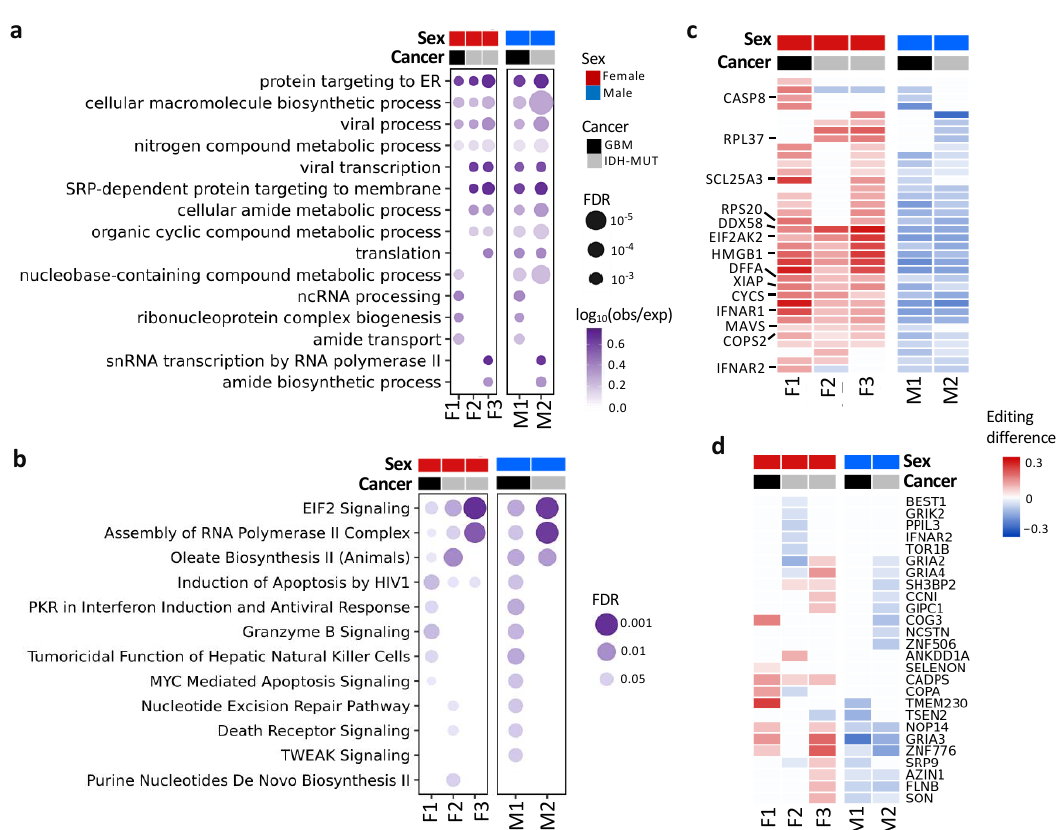
Figure 4. Functions and pathways associated with genes exhibiting differential editing. ( a ) Gene ontology enrichment analysis. ( b ) QIAGEN Ingenuity Pathway Analysis canonical pathway analy- sis. ( c ) Editing differences of selected genes associated with functions in ( a ) or ( b ). ( d ) Editing dif- ferences of sites in the coding regions. Comparisons are made between high- and low-risk GBM (F1: G 2 vs G 1 and M1: G 1 vs G 2 ) and IDH-MUT gliomas (F2: GH vs ODI 1 ; F3: ODI 2 vs ODI 1 and M2: GHI 1 vs GHI 2 ).